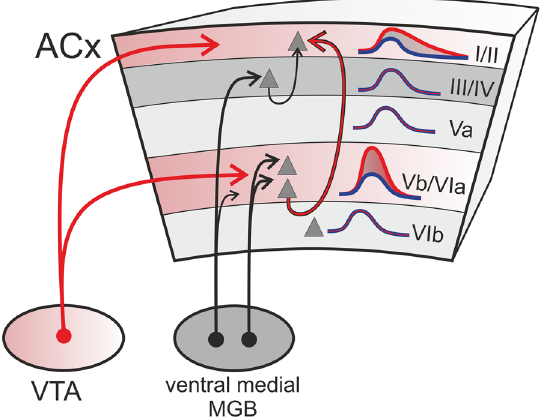
Figure 7. Schematic illustration of convergent deep layer inputs from sensory thalamus and VTA. VTA projections mainly target upper and infragranular layers of the gerbil auditory cortex (see also Fig. 1B). Stimulating the VTA projections led to a frequency-specific gain amplification of early sensory-evoked responses in thalamocortical recipient layers Vb/VIa. This gain increase effectuated an enhanced spectral tuning representation in supragranular layers I/II. The supragranular gain modulation might hence be inherited via intratelencephalic neurons targeting upper layers and bypassing granular input circuits 44 , may originate from a direct influence of dopamine released in upper layers or a combination of both. MGB, medial geniculate